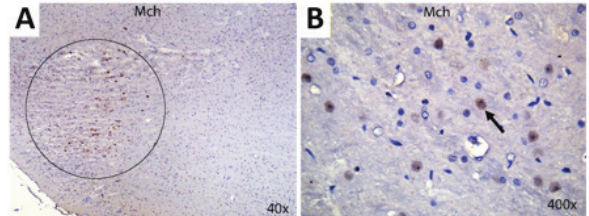
Figure 3: Melanin-concentrating hormone immunopositive (brown) cells on formalin fixed paraffin embedded rat brain slides, haema- toxylin counterstain. At low magnification (Panel A – 40x) there are strong immunoreactions in the hypothalamic area (circle). At higher magnification (Panel B - 400x) the reaction is limited to the cytoplasm